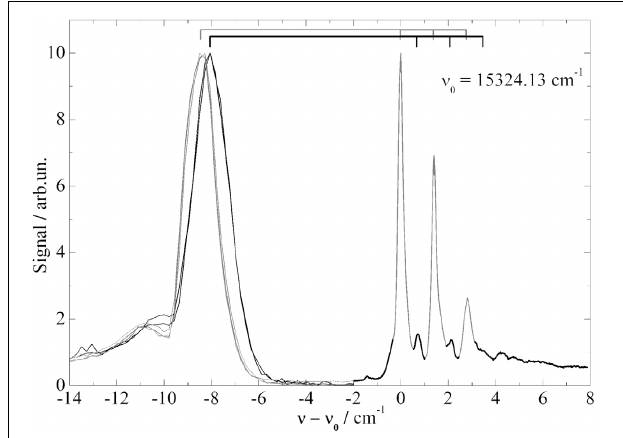
FIGURE 6 | Fluorescence excitation spectrum ( − 2 to 8cm − 1 ) and dispersed emission spectra ( − 14 to − 2cm − 1 ) of AlClPc in helium droplets. Correlation of excitation and emission spectrum is indicated by the two combs.